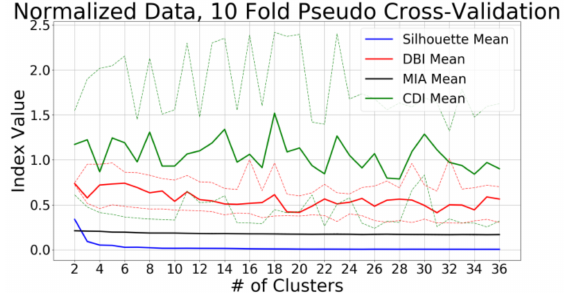
Figure 8. Cluster validation indicator development as a function of clusters. The silhouette and MIA validation indices were non-informative in this data set. While the CDI index exhibits large variation, there is no indication of optimum cluster selection, which was also the case for the DBI